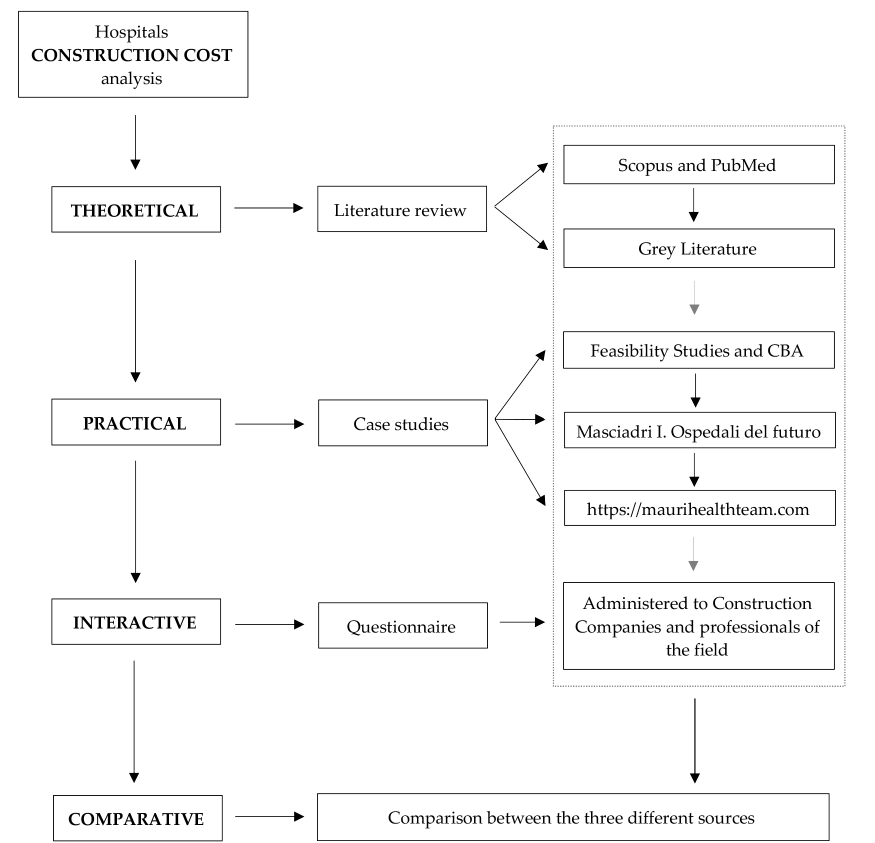
Figure 1. Methodological approach flowchart with the identification of the four phases.